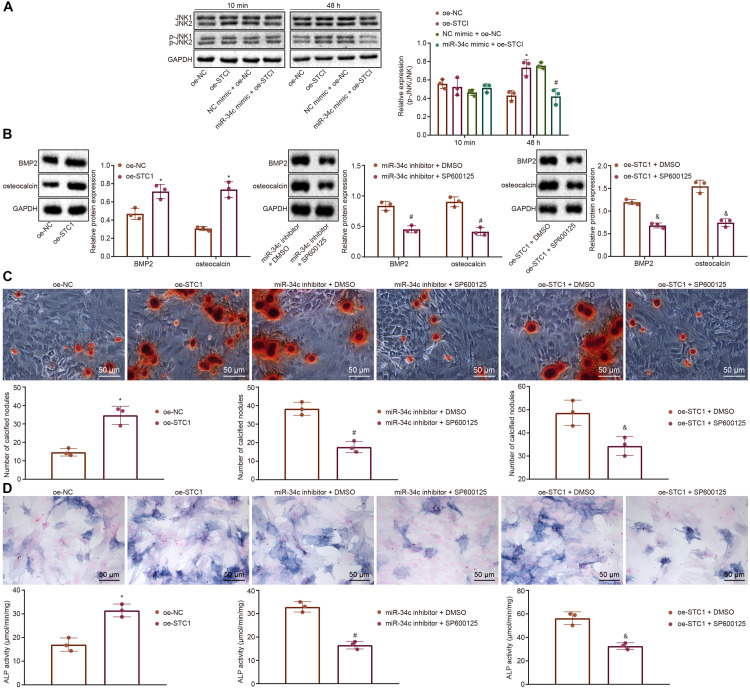
MiR-34c plays a role in CAVD via mediating JNK pathway by inhibiting STC1. (A) The phosphorylation level of JNK pathway in VICs with different treatments evaluated by western blot analysis. (B) The protein expression of BMP2 and osteocalcin determined by western blot analysis. (C) Alizarin red staining (×200) of calcification. (D) The staining figure of ALP (×200) and ALP quantitative activity analysis. Data are expressed as mean ± standard from at least three independent experiments. The comparison between two groups was checked by unpaired Student’s t test. *p < 0.05 vs. VICs transfected with oe-NC. #p < 0.05 vs. VICs transfected with NC mimic + oe-STC1 or miR-34c inhibitor + DMSO. &p < 0.05 vs. VICs treated with oe-STC1 + DMSO.